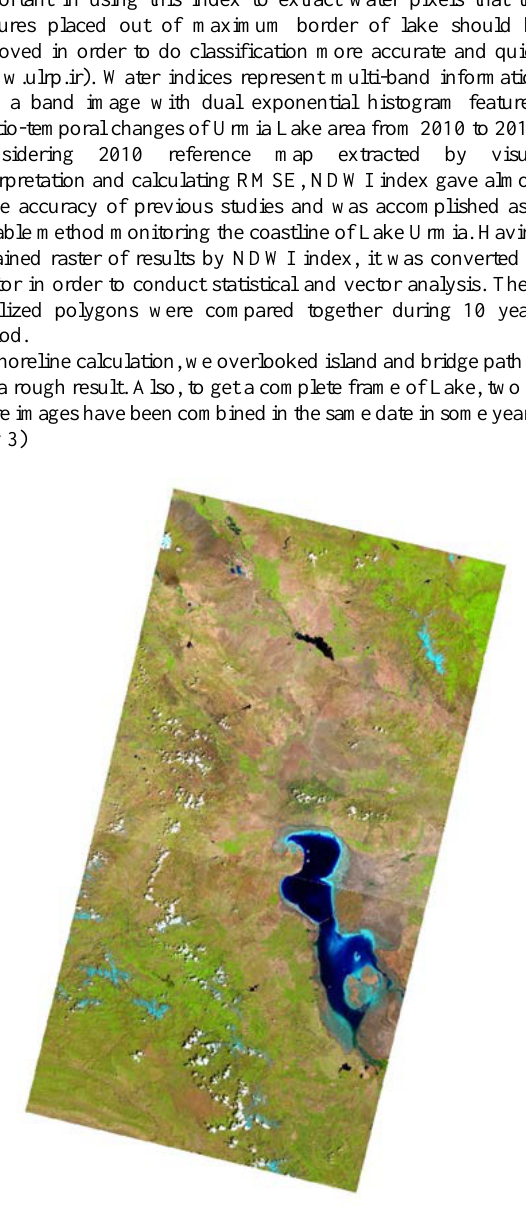
Figure 3. Combining two frames of